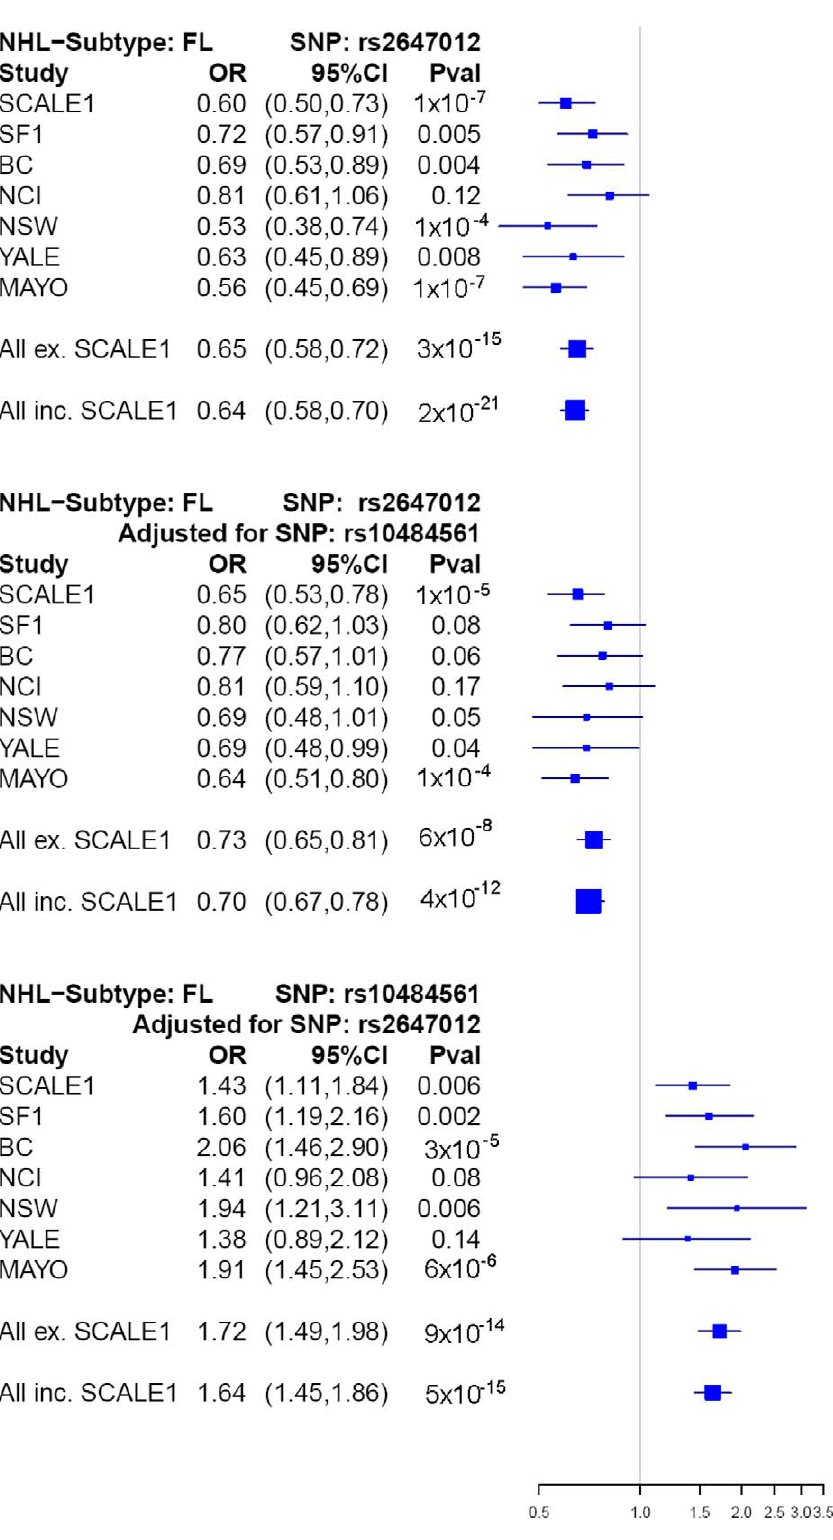
Figure 3. Forest plots of main associations with risk of FL. Forest plots showing the associations in each study (ORs and P-values) at rs2647012 before adjustment (P heterogeneity =0.32), and at rs2647012 (P heterogeneity =0.67) and rs10484561 (P heterogeneity =0.54) after mutual adjustment. Squares indicate the odds ratios, with the size proportional to the weight of the study in the meta-analysis. Abbreviations: CI: confidence interval, SCALE: Scandinavian lymphoma etiology, SF: San Francisco, BC: British Columbia, NCI: National Cancer Institute-Surveillance, Epidemiology and End Results, NSW: New South Wales, YALE: Yale University, MAYO: Mayo Clinic.